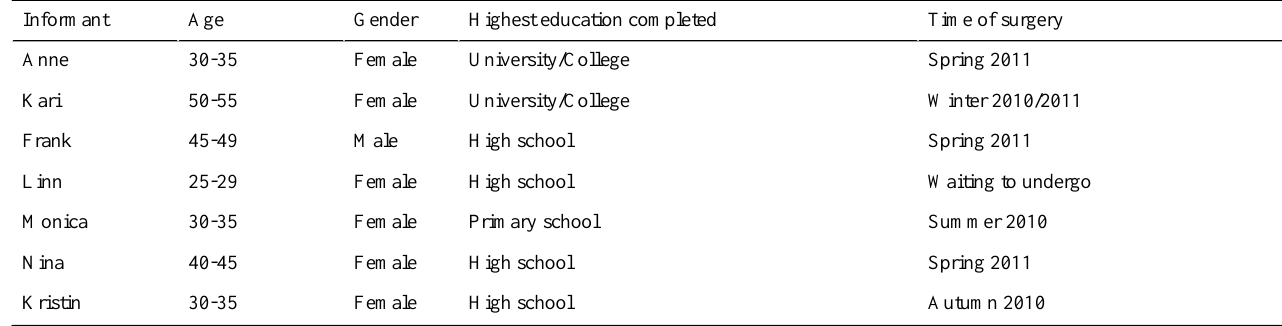
Table 2. Demographic data, interview